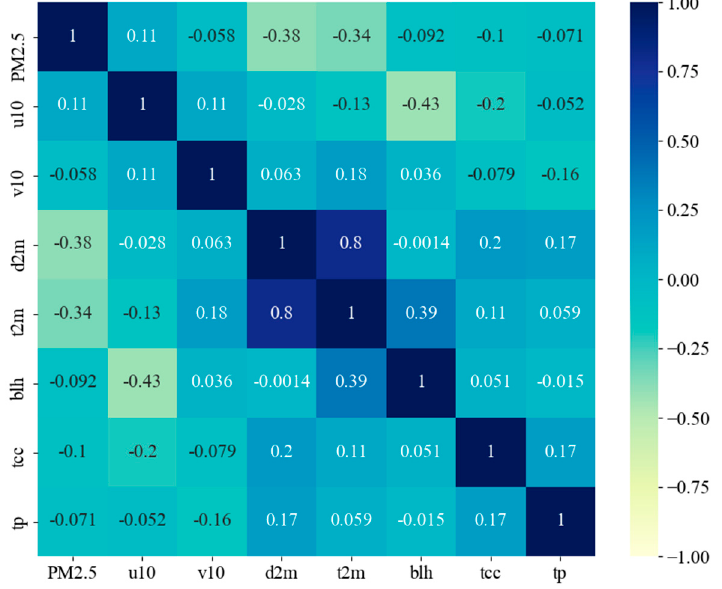
Figure 2. Map of the correlation coefficient between the PM 2.5 concentration value and meteorological environment field data.